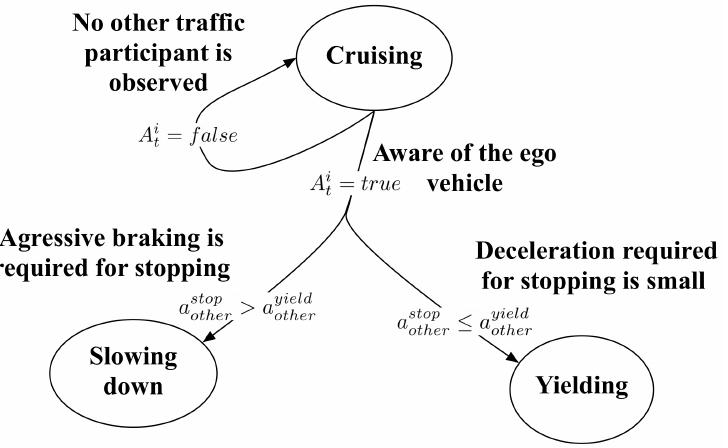
Figure 12. Proposed behavior transition of an approaching vehicle at a blind intersection.